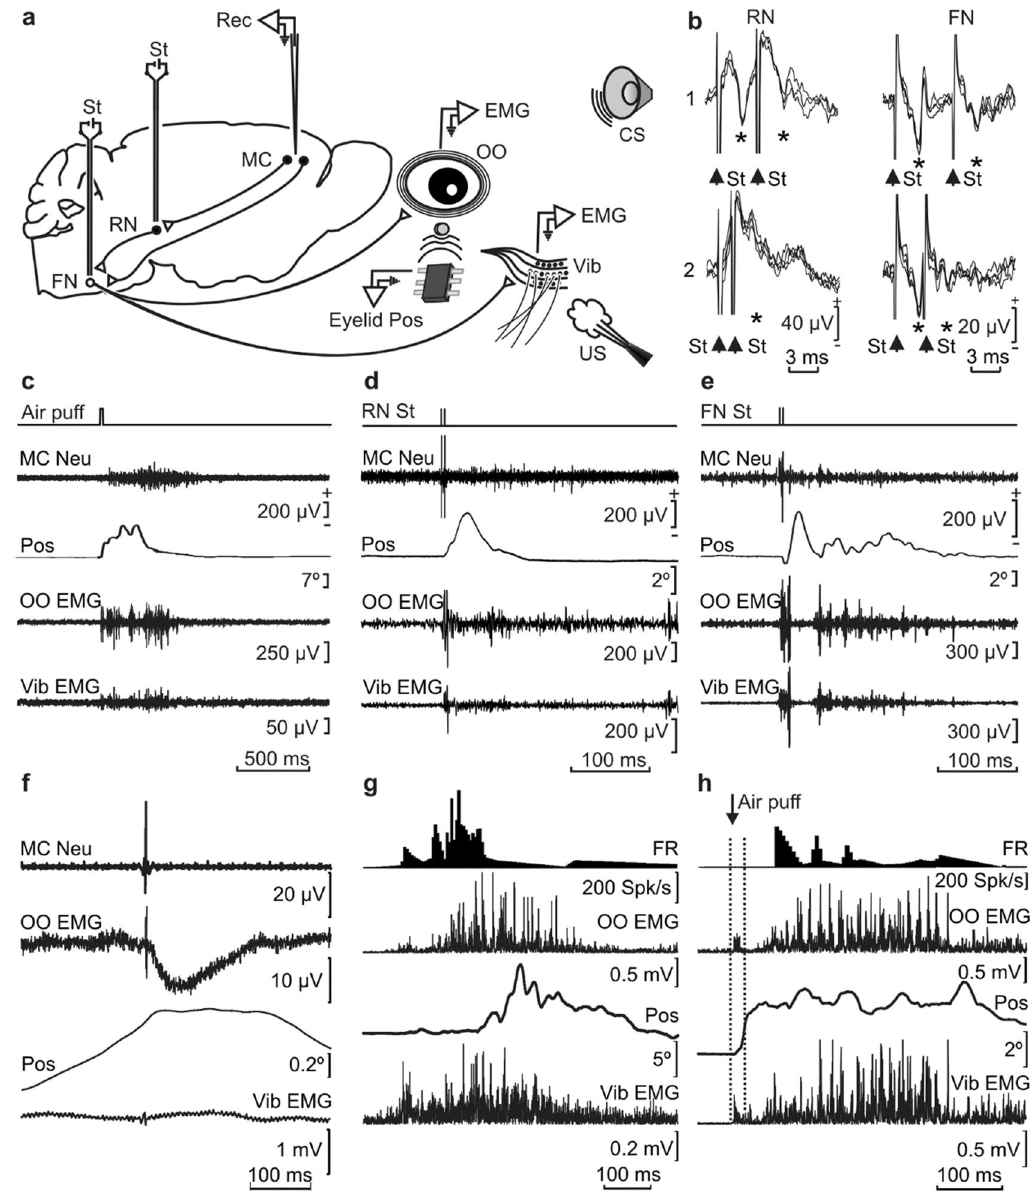
Figure 1. Experimental design and identification of recorded MC neurons. ( a ) Diagrammatic representation of the experimental design. Mice were chronically implanted with EMG recording electrodes in the right OO and Vib muscles. A loudspeaker was used to provide a tone as CS and an air compressor to present an air-puff to the right cornea and vibrissae as US. Eyelid position (Eyelid Pos) was determined as the voltage difference between a Hall-effect sensor located on the head-holding system and a small magnetic piece affixed to the right lower eyelid. Left MC neurons were recorded (Rec) with glass micropipettes and identified by their antidromic stimulation (St) from the left red nucleus (RN) or the right facial nucleus (FN). Ipsilateral and contralateral neurons are represented by white and black circles, respectively. ( b ) Overlapped (n = 6–8) traces of the antidromic activation (*) of representative MC neurons from the RN and FN (St) at threshold-straddling intensities and at different (RN-1, 3 ms; RN-2, 1.5 ms; FN-1, 6 ms; and FN-2, 3 ms) interstimulus intervals. Note in RN-2 and FN-2 that the antidromic activation was partially prevented. Arrows indicate stimulus artifacts. ( c – e ) Representative examples of the firing rate of MC neurons following the presentation of an air-puff aimed at the cornea ( c ), and of RN ( d ) and FN ( e ) stimulations, with 3 ms of interstimulus intervals. Eyelid position (Pos), OO EMG, and Vib EMG are also illustrated. ( f ) Spike-triggered activity recorded in the OO muscle (OO EMG). The triggering action potential corresponded to an identified MC neuron (MC Neu). Average was repeated 2000 times. Lower eyelid position (Pos) and EMG activity recorded in the Vib muscle are also indicated. ( g , h ) Typical firing rate (FR) of MC neurons recorded during the performance of a spontaneous blink ( g ) and following a strong air-puff stimulation ( h ). OO EMG, Vib EMG, and lower eyelid position (Pos) are also